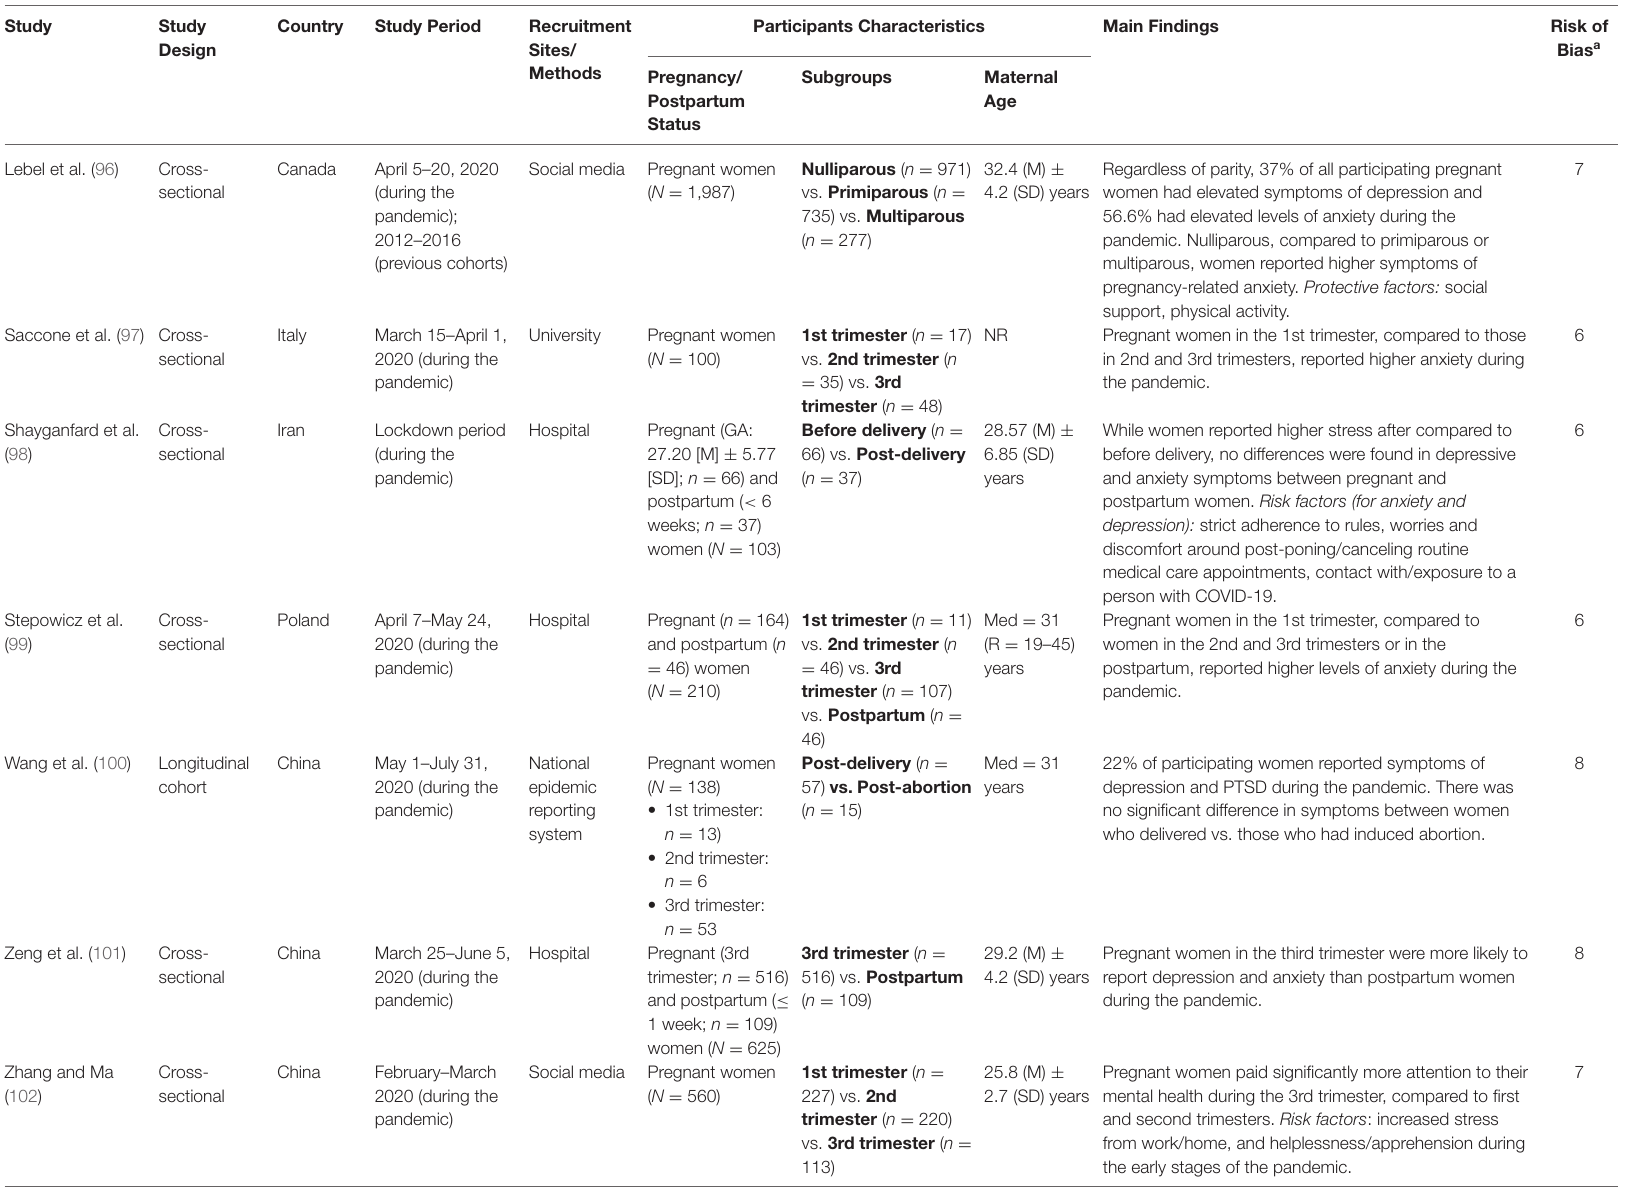
TABLE 5 | Perinatal mental health outcomes during COVID-19 as a function of pregnancy-related factors (e.g., stage of pregnancy/postpartum,